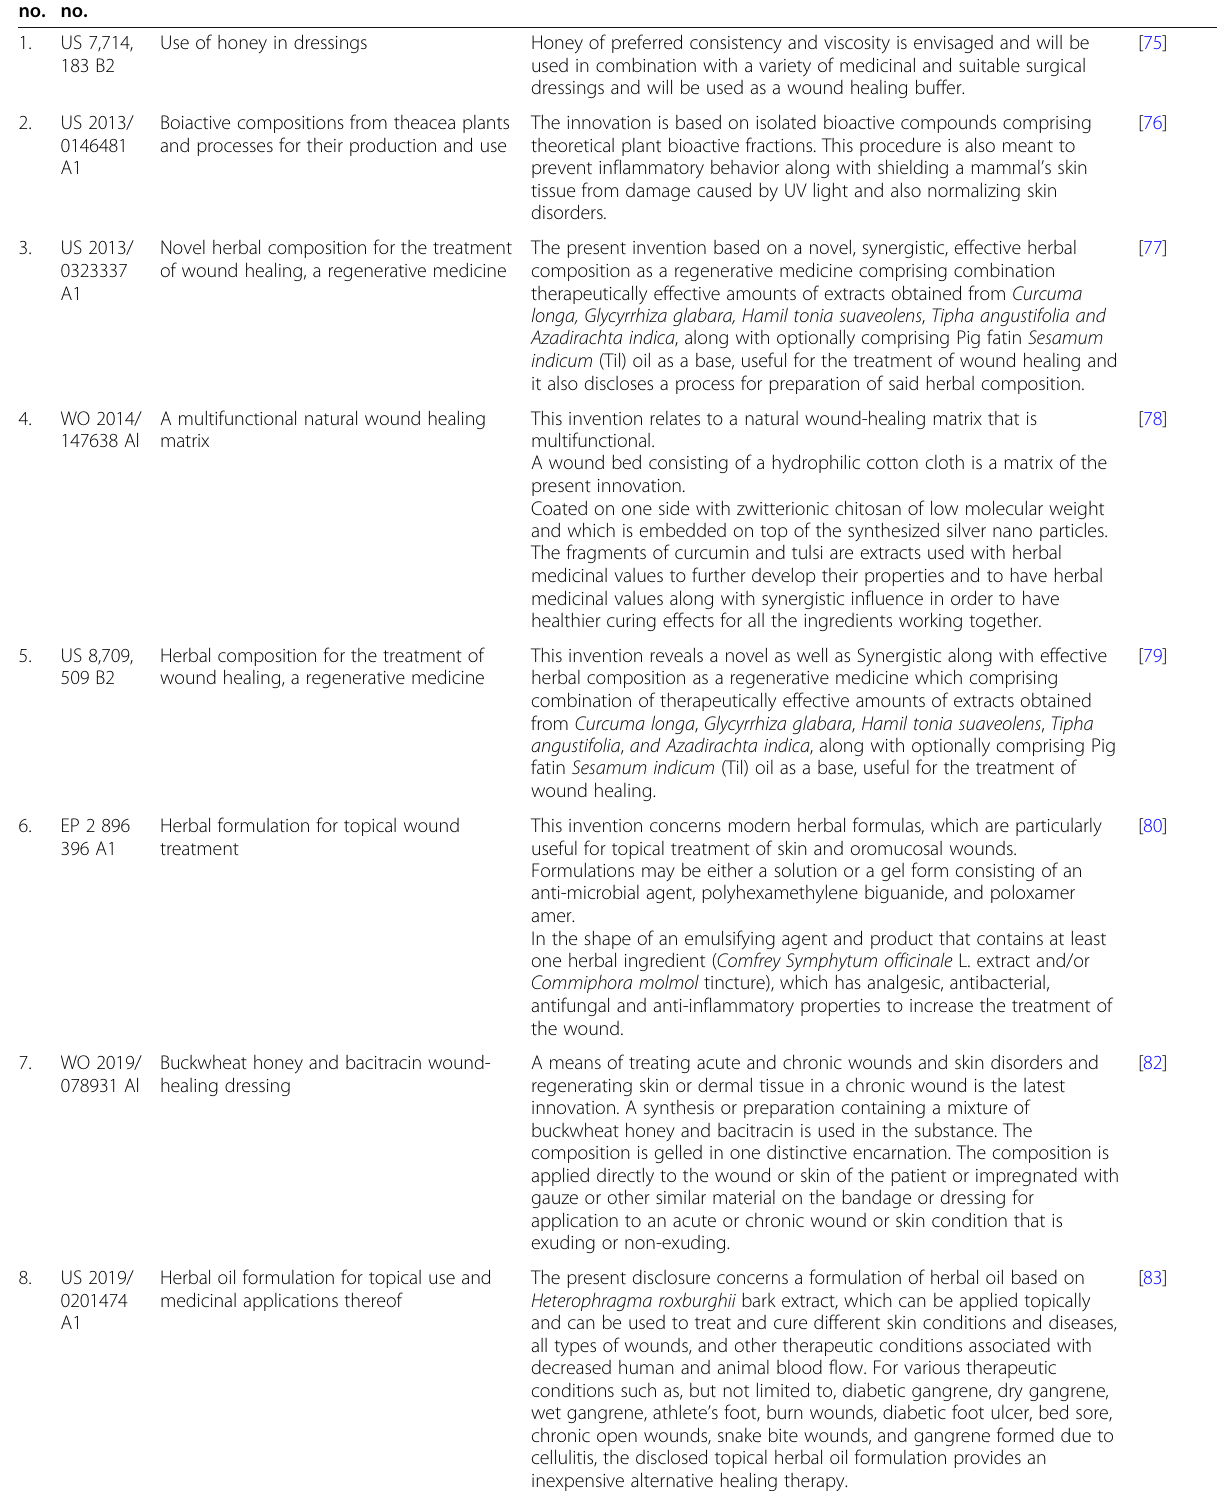
Table 3 Medicinal plant constituent based patented technologies for wound healing